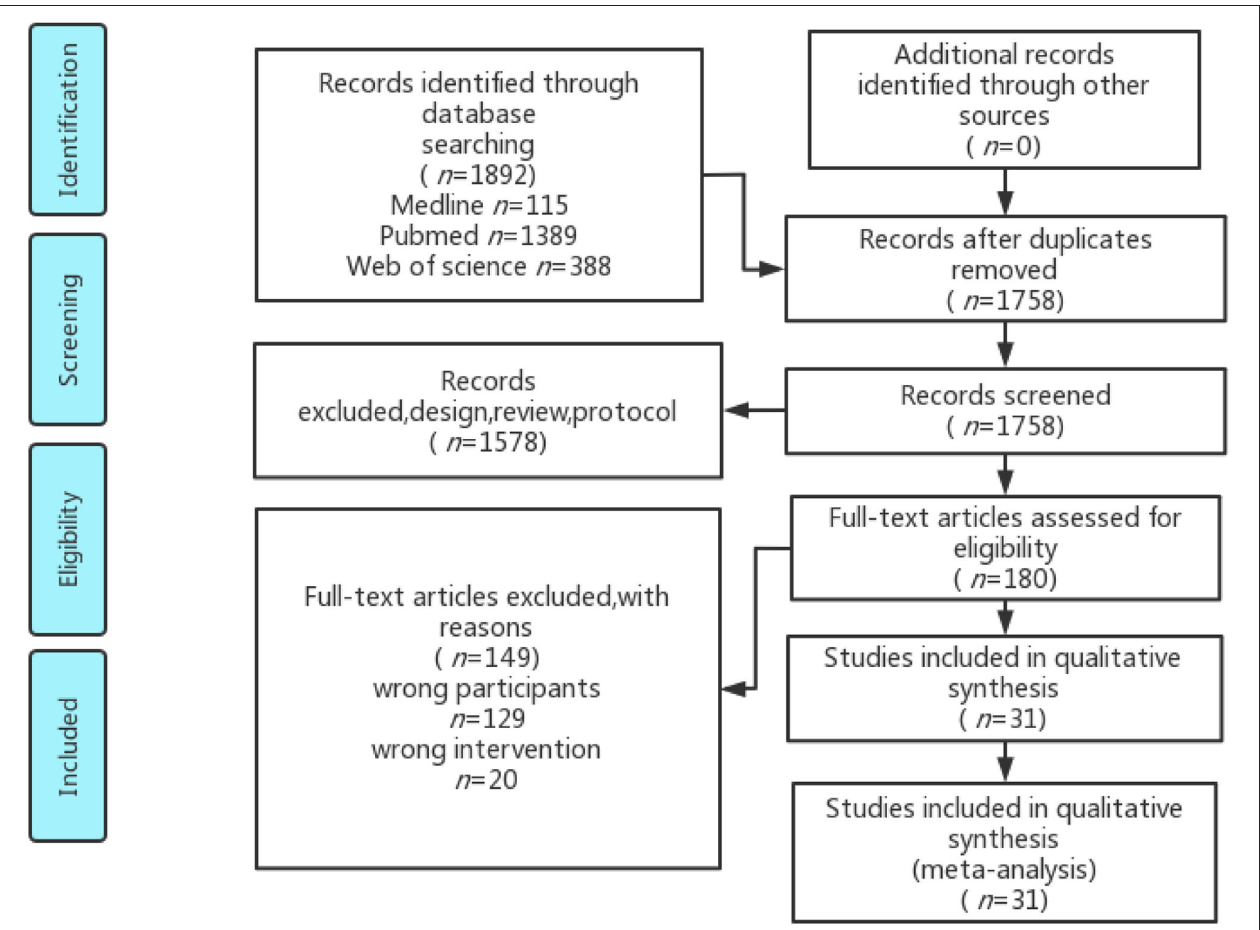
FIGURE 1 | The PRISMA 2009 flow diagram of the search and study